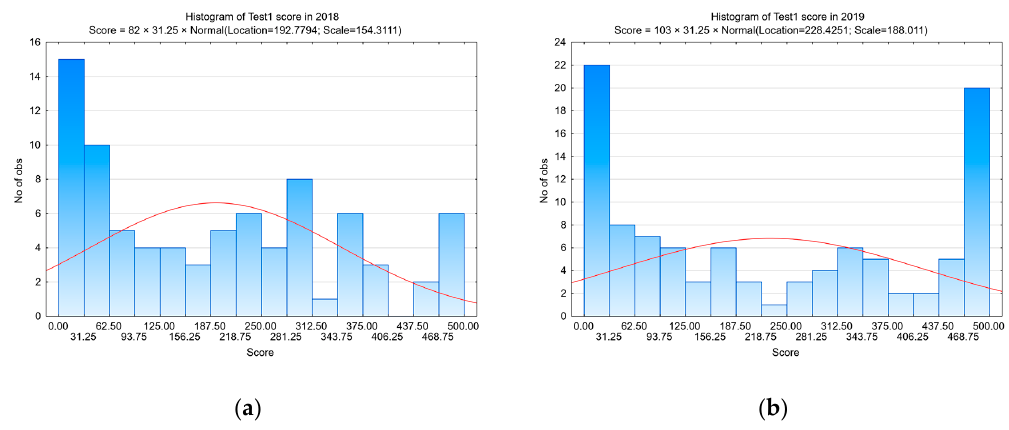
Figure 7. Histogram of test score distribution in monitored groups: ( a ) Test score in the group trained without microlearning in 2018; ( b ) Test score in the group of students taught with microlearning in 2019.